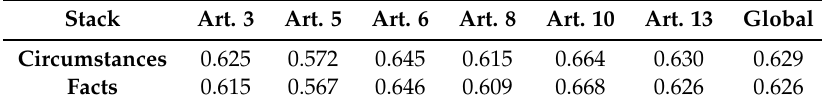
Table 5. Individual and global accuracies for the stack dataset (PLS + SVM models).